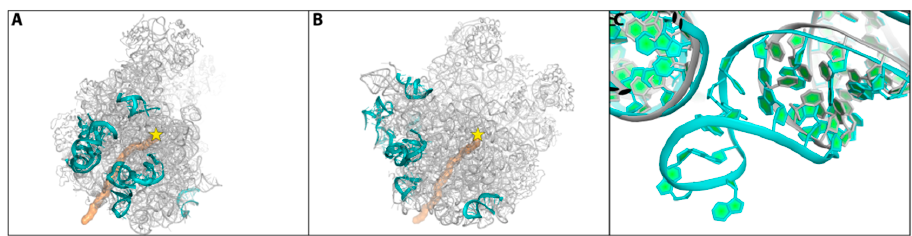
Figure 5. Left: The backbone of the large ribosomal subunit of SA50S is shown in gray from two views (face on ( A ) and a rotation of 90° ( B )). The polypeptide exit tunnel is shown in gold and the PTC location is marked by a yellow star. The rRNA regions with fold variability compared with all other known structures on the SA50S surface are shown in cyan. Right: The stem loop of helix H63 in SA (cyan) and of Deinococcus radiodurans D50S (grey). Panel A & B are adapted from [16].